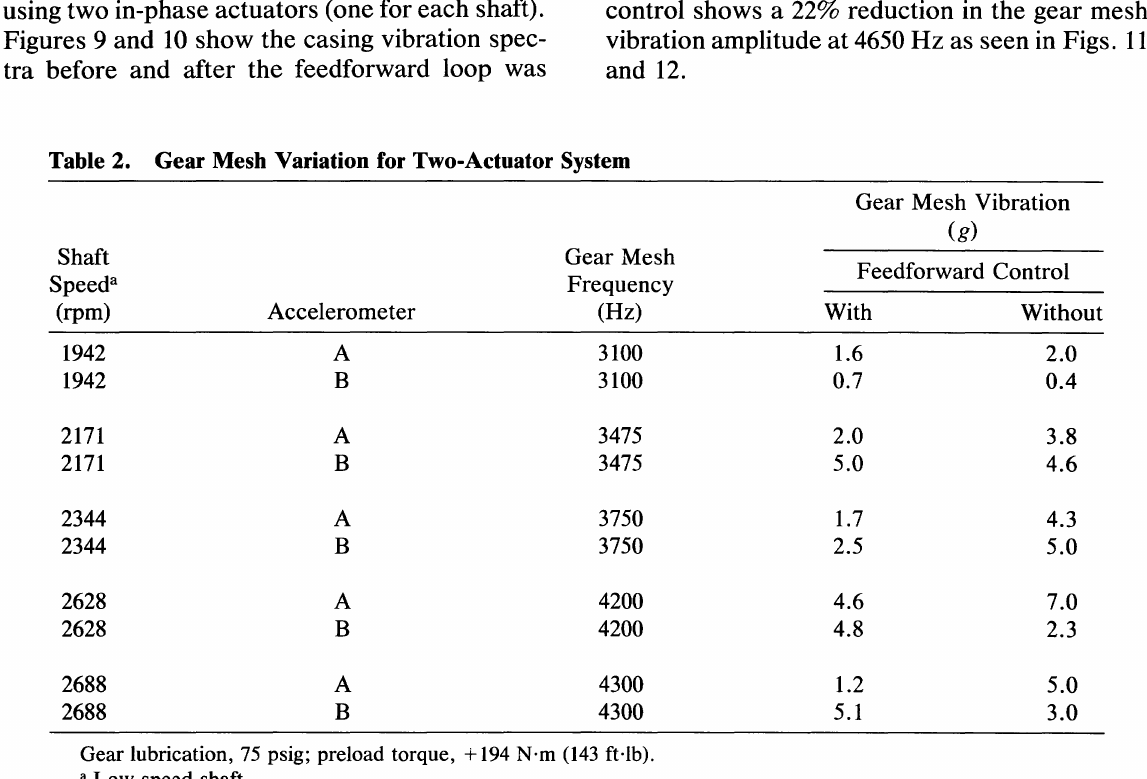
Table 2. Gear Mesh Variation for Two-Actuator System